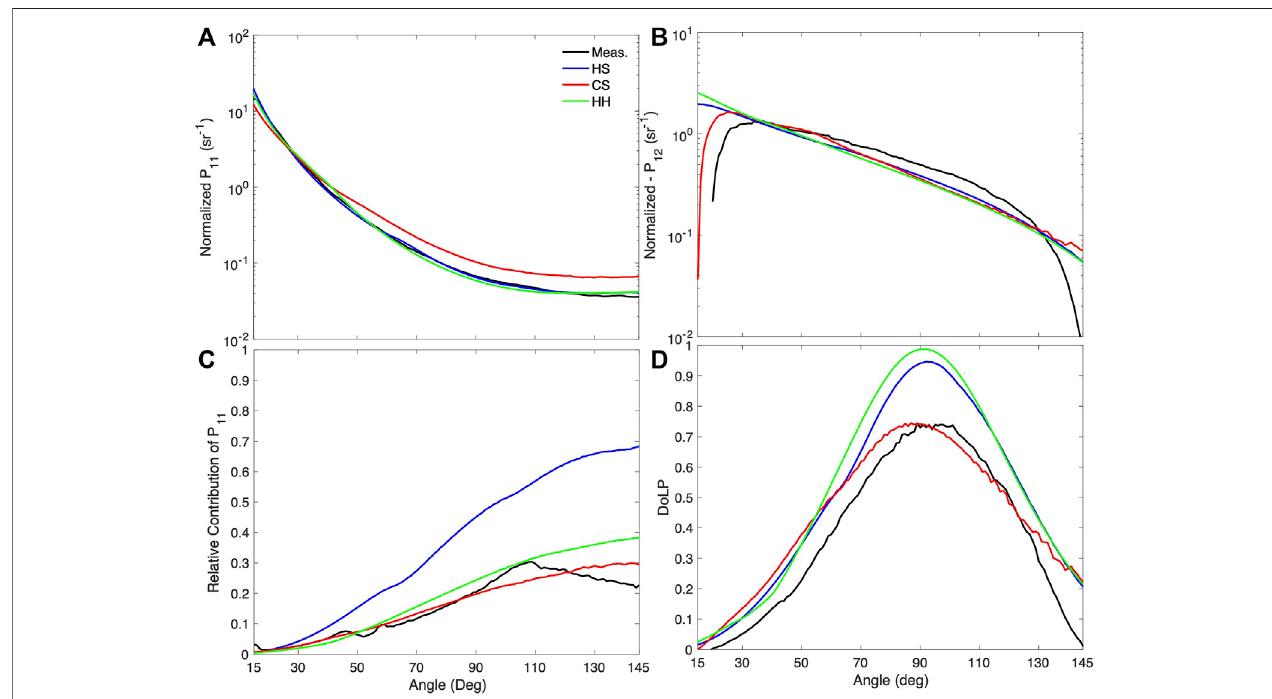
FIGURE 10 | Comparison of angular scattering features measured during NPO-18 and simulated using homogeneous sphere model (HS), homogeneous hexahedral model (HH), and the mix of homogeneous/coated sphere model (CS). (A) P 11 for bulk particles, (B) − P 12 for bulk particles, (C) the relative contribution by particles < 0.2 μ m to P 11 , and (D) degree of linear polarization (DoLP) for bulk particles.